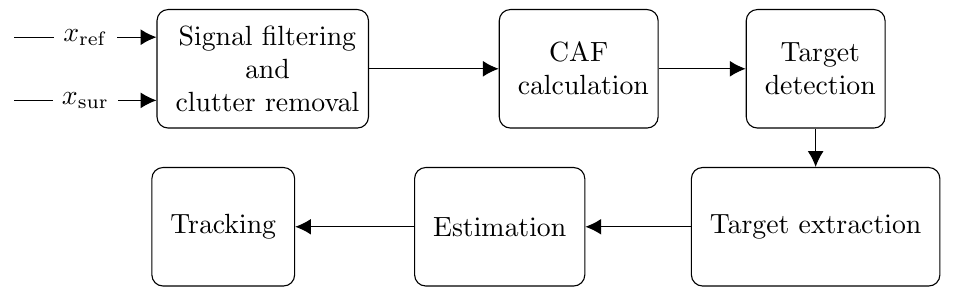
Figure 2. PCL radar processing